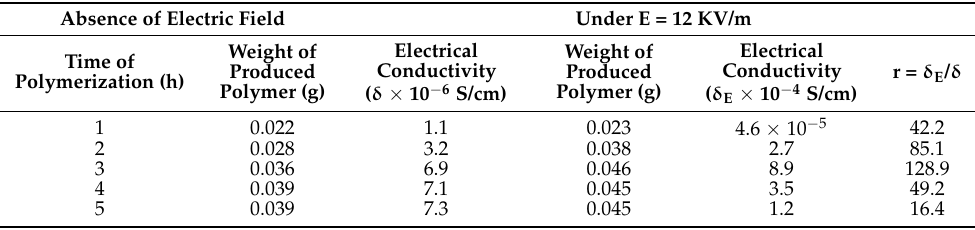
Table 4. Electrical conductivity of polycarbazole produced with FeCl 3 (dry) (PTSA 1M in acetone) as the initiator (1/5 mol ratio) at different times, in the absence and presence of a 12 KV/m electric field. Absence of Electric Field Under E = 12 KV/m Electrical Weight of Weight of Time of Conductivity Produced Polymerization (h) Polymer (g)